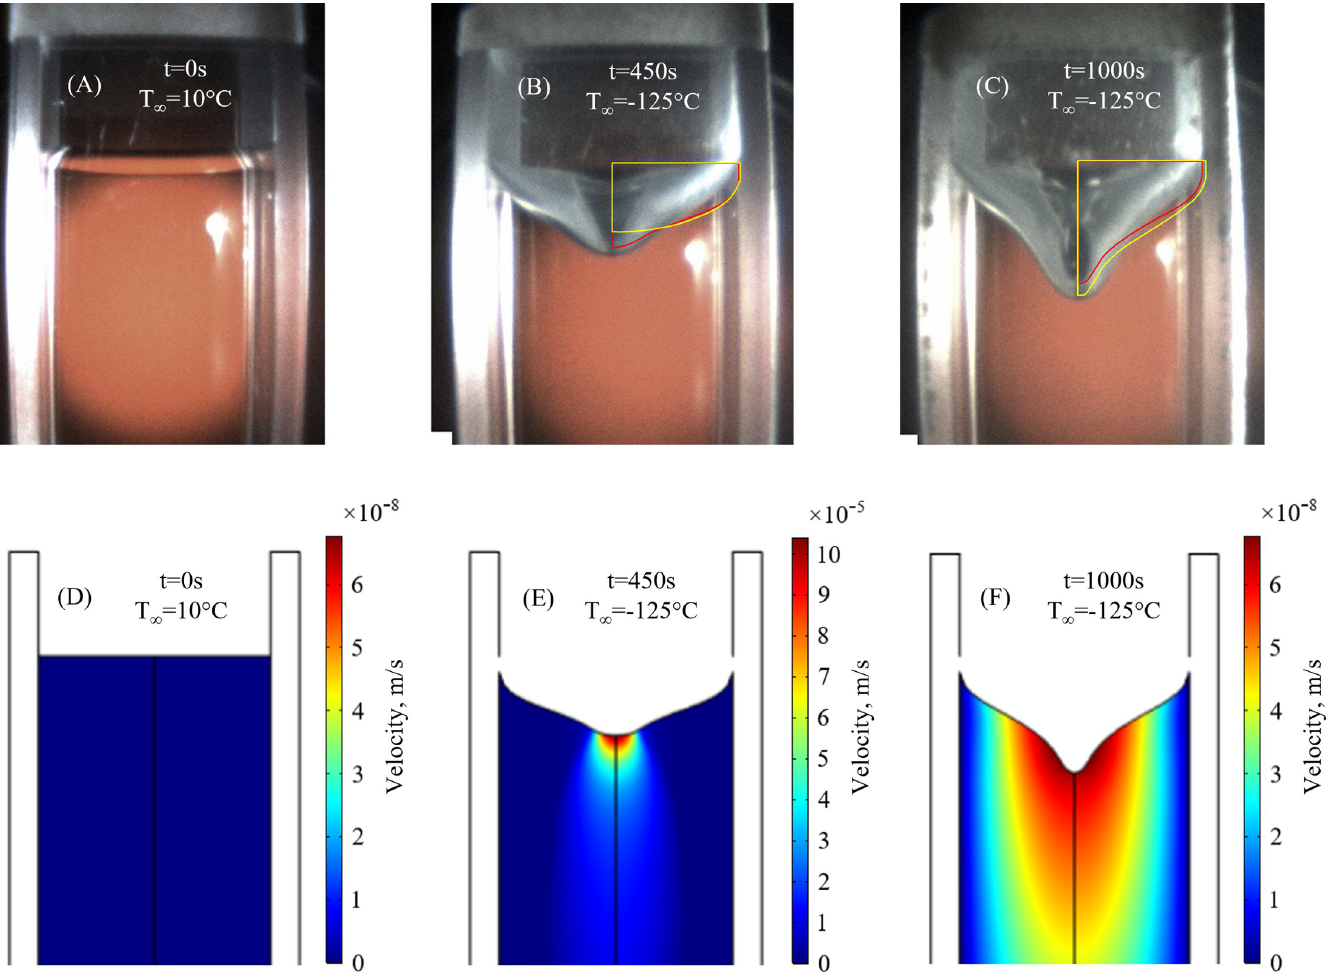
Fig 4. Comparison of experimental results with mathematical modeling, subject to an initial temperature of 10˚C and a cooling rate 20˚C/min. (A)-(C) display the snapshots of the deformed surface at different times, while (D)-(F) display the 2D TF modeling results, respectively. In addition, the overlayed red and yellow curves on the snapshots display the deformed surface base on the 2D and the 3D TF problem, respectively. Note the different velocity field scales.